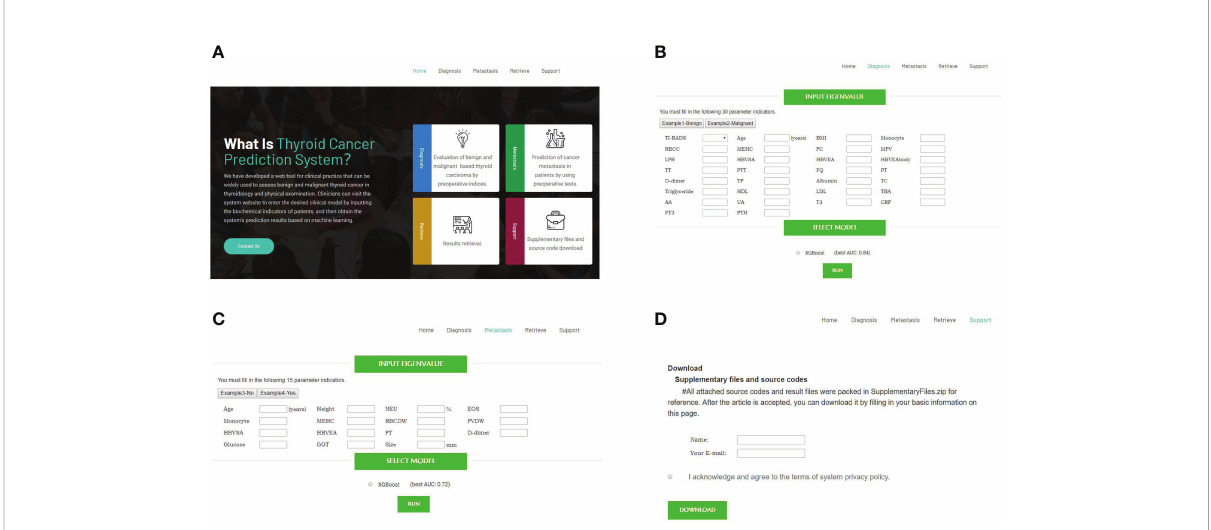
FIGURE 6 Web-based tools for diagnosis of malignant and metastasis TC using preoperative laboratory tests and demographic characteristics (http://www. cancer-thyroid.com/). (A) Main page. (B) Diagnosis page. (C) Metastasis page. (D) Supplementary fi les and source